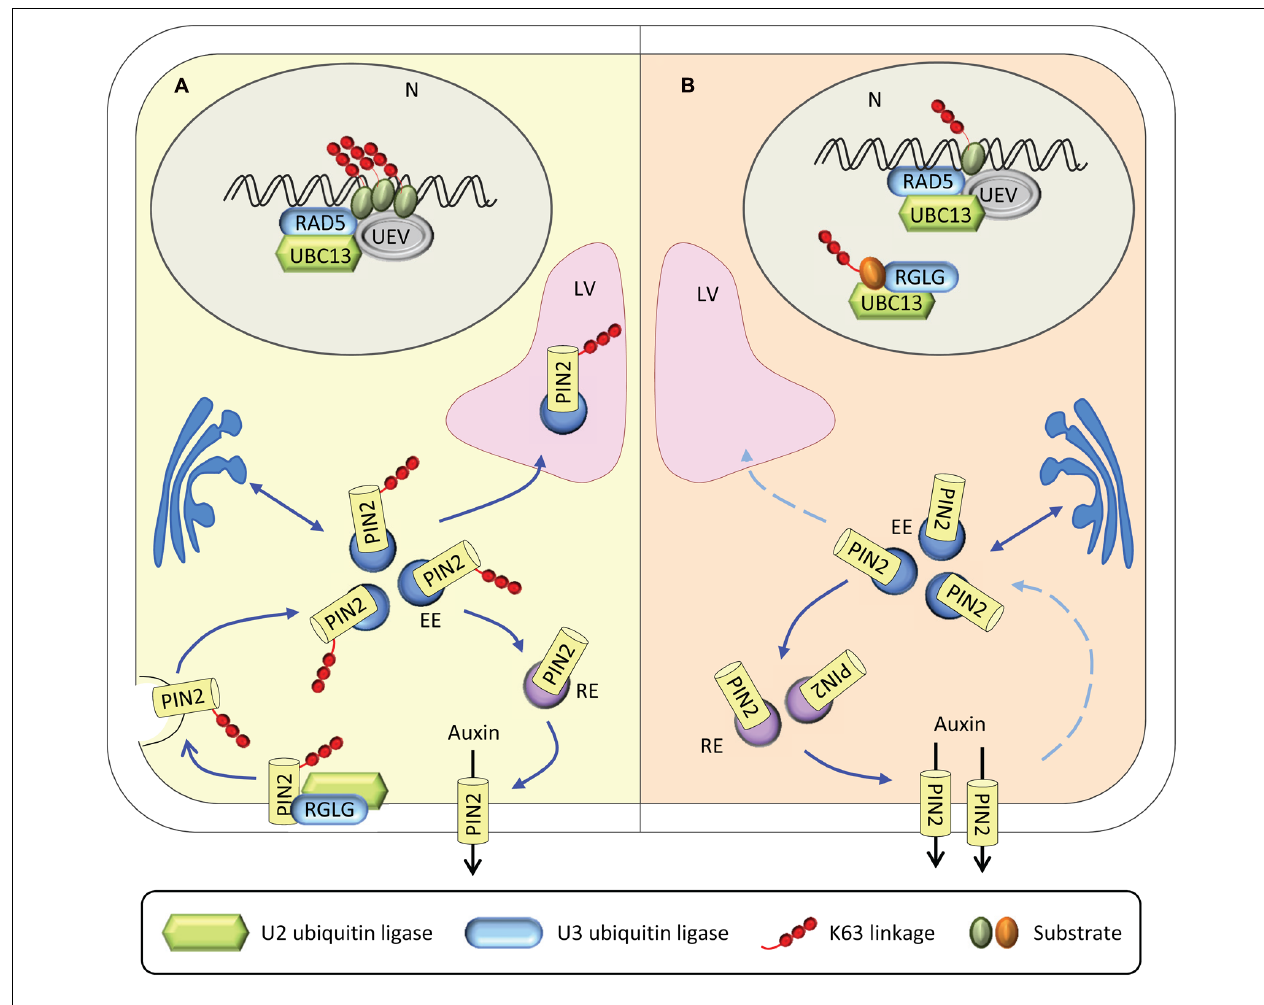
nucleus where it interacts with UBC13. UBC13-RGLG1/2 might be associated with DNA repair or with other processes related to genome stability. Loss of PIN2 ubiquitination cause a cessation of endocytotic PIN2 cycling, thereby altering auxin distribution. N, nucleus; LV, lytic vacuole; EE early endosome; RE, recycling